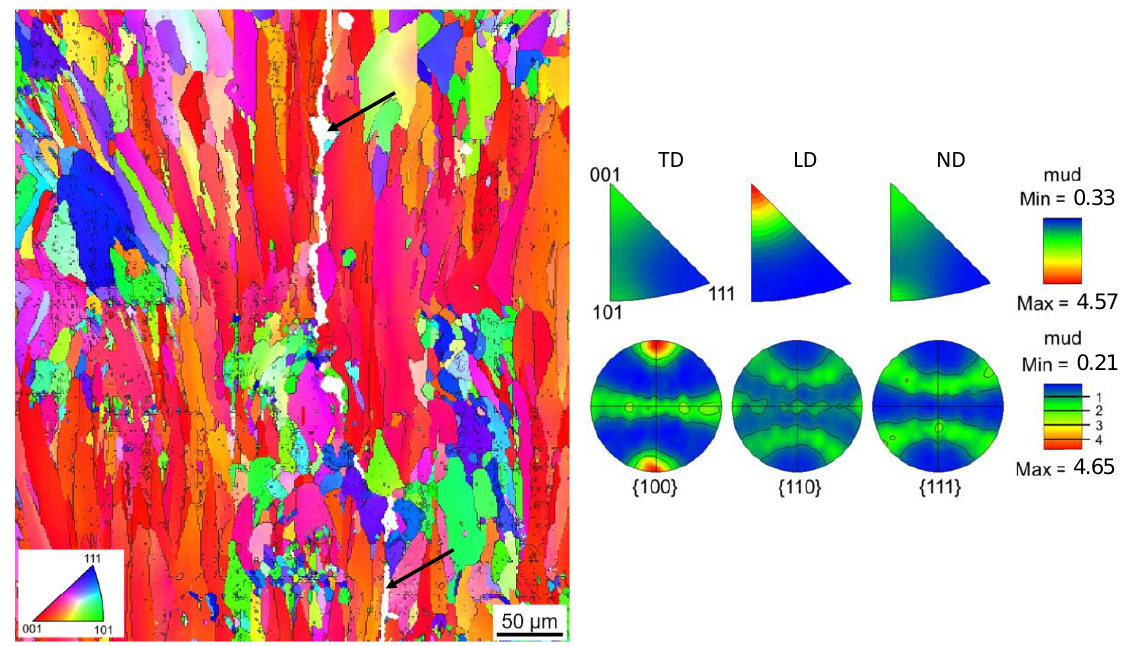
Figure 3. EBSD micrograph in longitudinal direction (or building direction) and inverse pole figures of the LPBF specimen manufactured with the pre-alloyed 6182 powder. Black arrows indicate hot cracks.